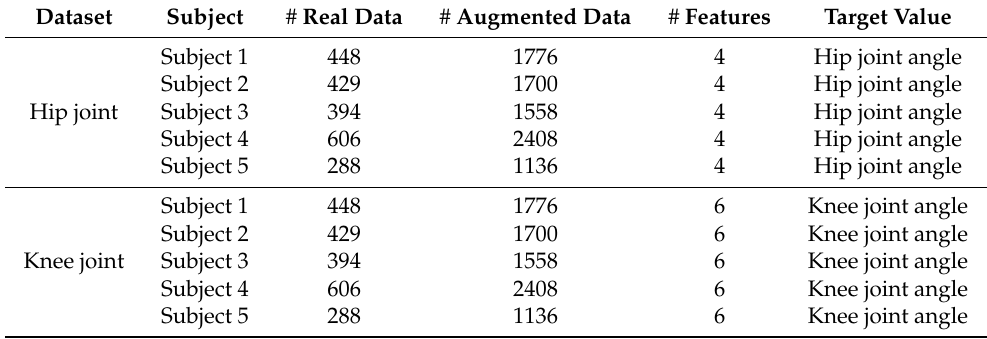
Table 2. Details of the